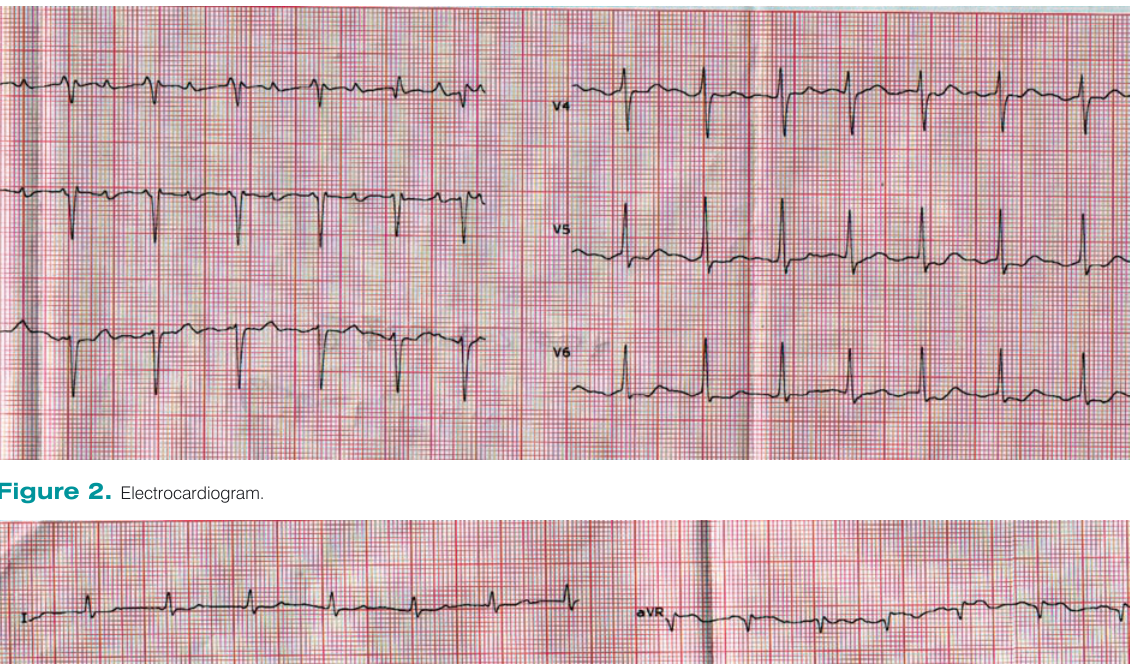
Figure 1. Electrocardiogram.